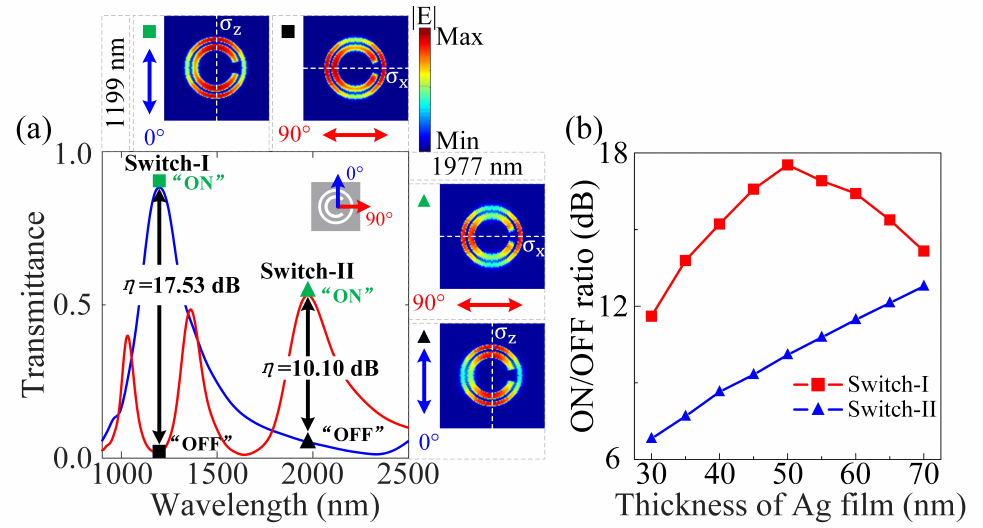
Figure 6. Passive dual-wavelength plasmonic switches with in-plane mirror symmetry and mirror asymmetry along the X- ( σ x ) and Z-axes ( σ z ), respectively. ( a ) The passive plasmonic switches versus the wavelength with different polarization angles of incident light in the near-infrared region. The high ON/OFF ratios are 17.53 dB and 10.10 dB for the resonance center wavelengths at 1199 nm and 1977 nm, respectively. The corresponding electric field distributions of the hybrid RMM are shown in the insets. ( b ) For the resonance center wavelengths at 1199 nm and 1977 nm, the ON/OFF ratios change with the increase in the thickness of Ag film. The opening angle ( α ) of the hybrid metasurface is fixed as 30°, with the other parameters being the same as Figure